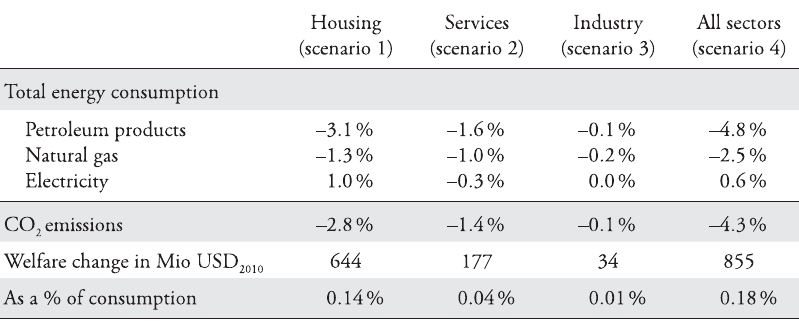
Table 4: Impacts of a Climate Change Induced Reduction in Heating